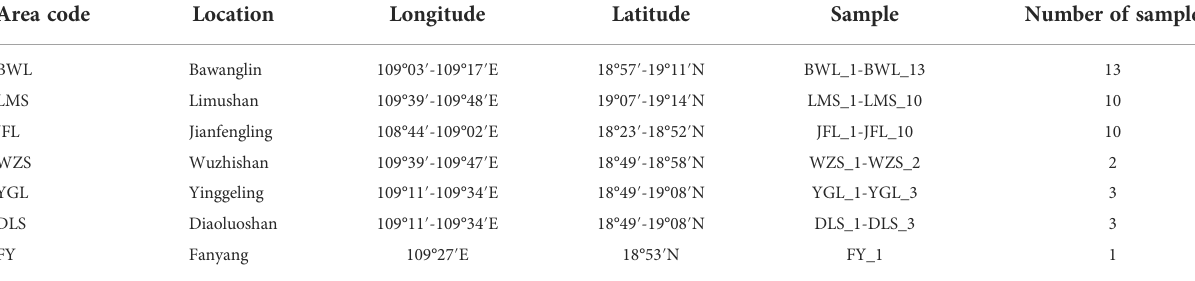
TABLE 1 The list of information for Hopea hainanensis sample collection in Hannan